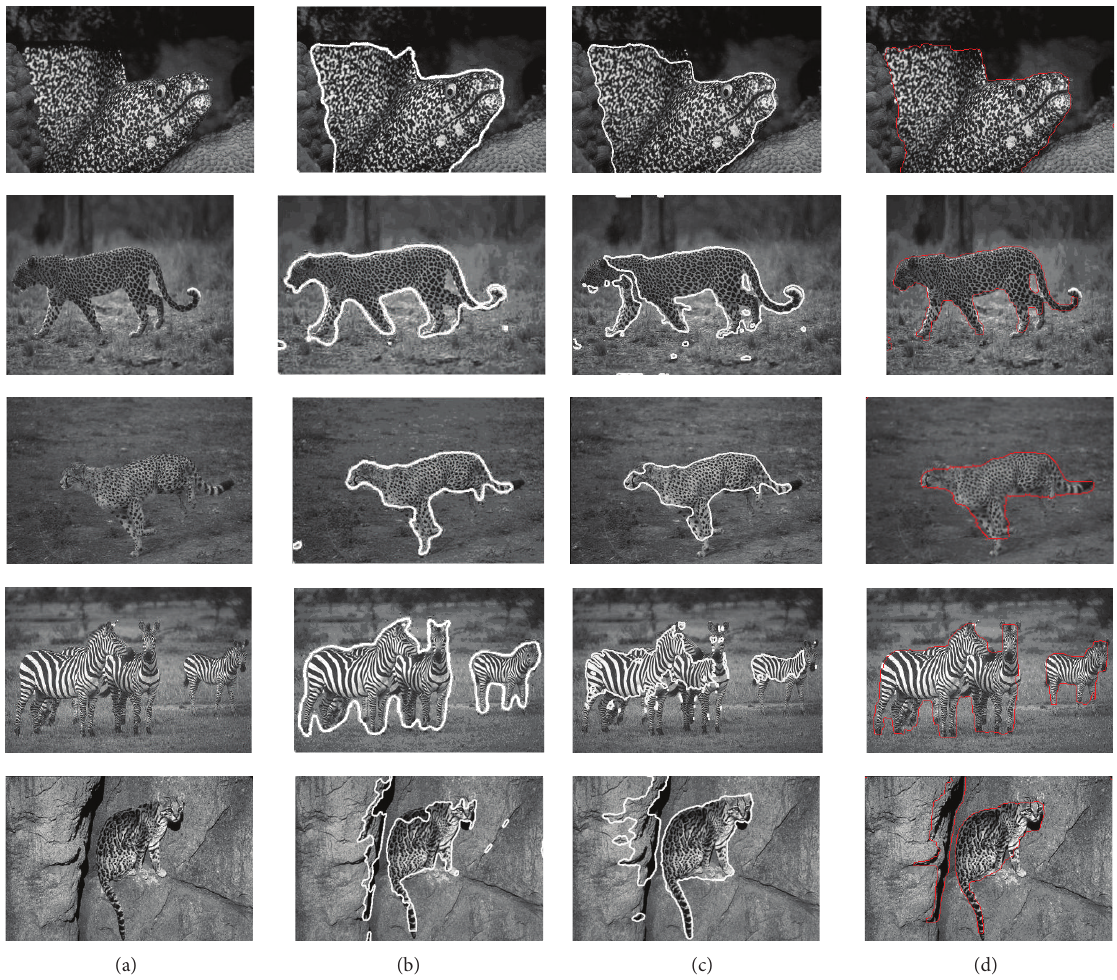
Figure 5: Comparison results between our method and state-of-the-art methods in [22, 34]: (a) shows the original natural textural images; (b) shows the results using methods in [34]; (c) shows the results using methods in [22]; (d) shows the results of our